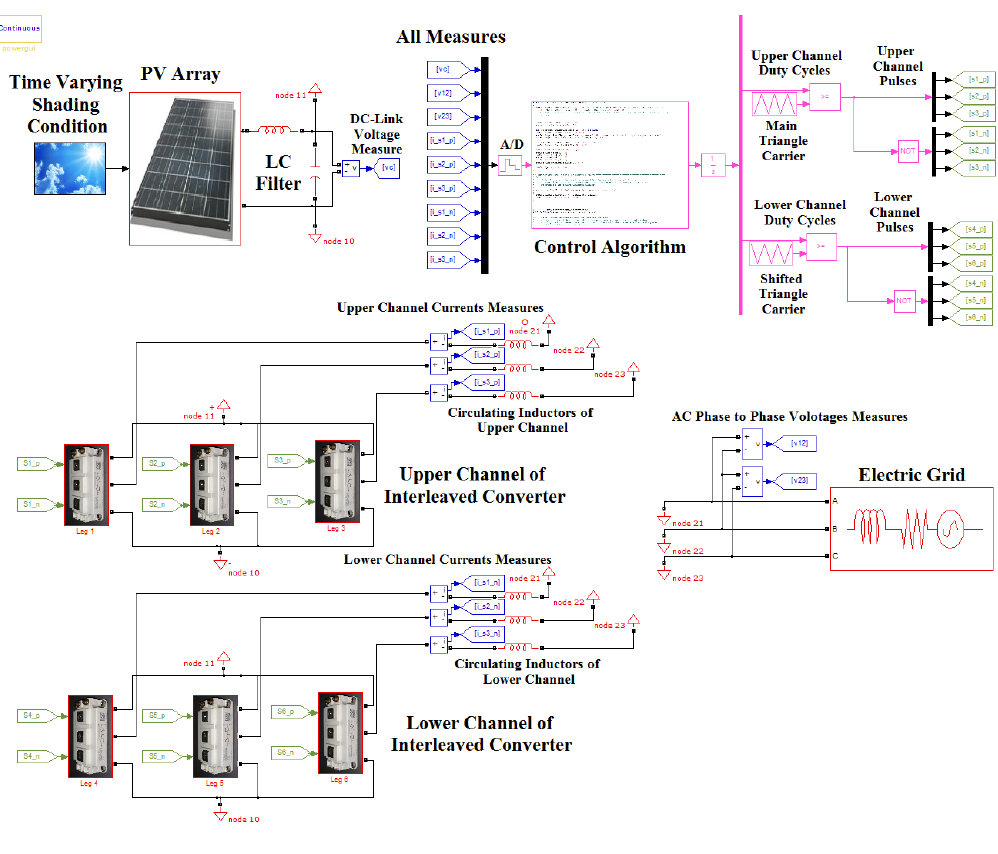
Figure 6. Simulink model of the controlled system.